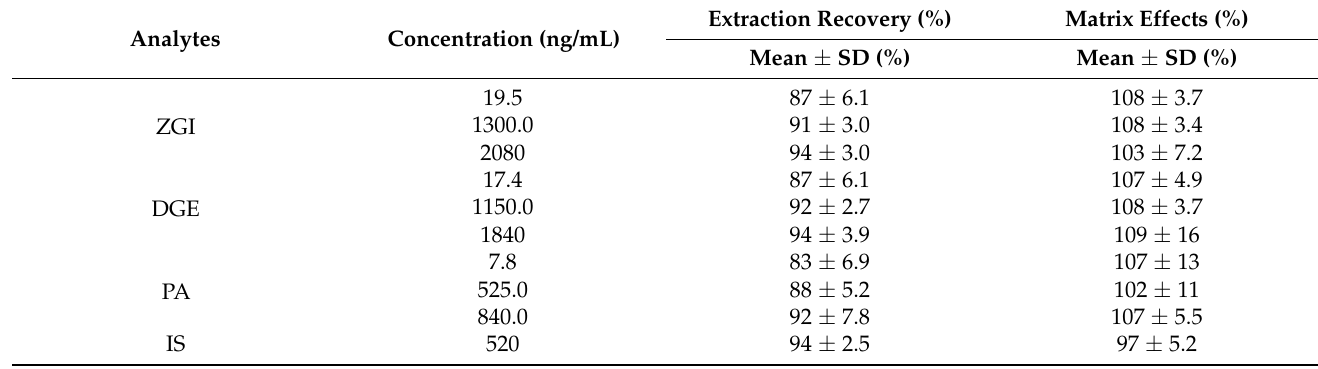
Table 3. Matrix effects and extraction recoveries for analytes and IS in rat plasma ( n =